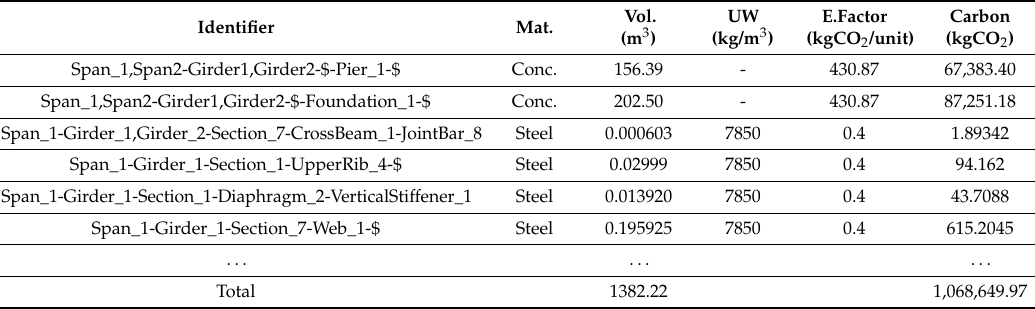
Table 6. The estimated results of the carbon emission of a steel box girder bridge